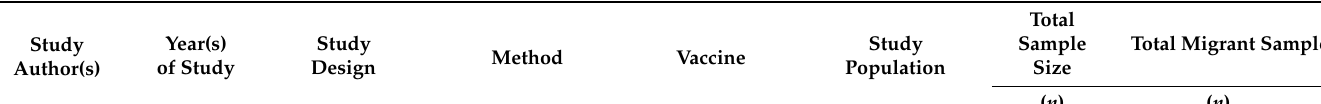
Table A1. Detailed characteristics of the included studies in the